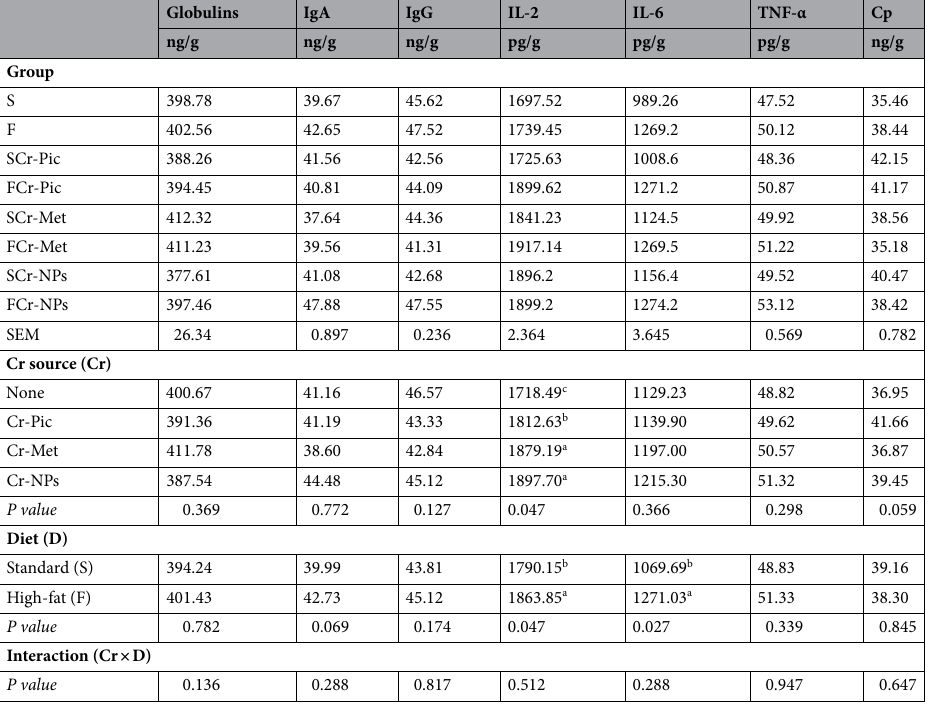
Table 2. Immune status parameters of the ileal tissue of rats fed experimental diets. S—Rats fed a standard diet; F—rats fed a high-fat, low-fibre diet; SCr-Pic—rats fed diet S supplemented with 0.3 mg Cr/kg BW from chromium(III) picolinate; FCr-Pic—rats fed diet F supplemented with 0.3 mg Cr/kg BW from chromium(III) picolinate; SCr-Met—rats fed diet S supplemented with 0.3 mg Cr/kg BW from